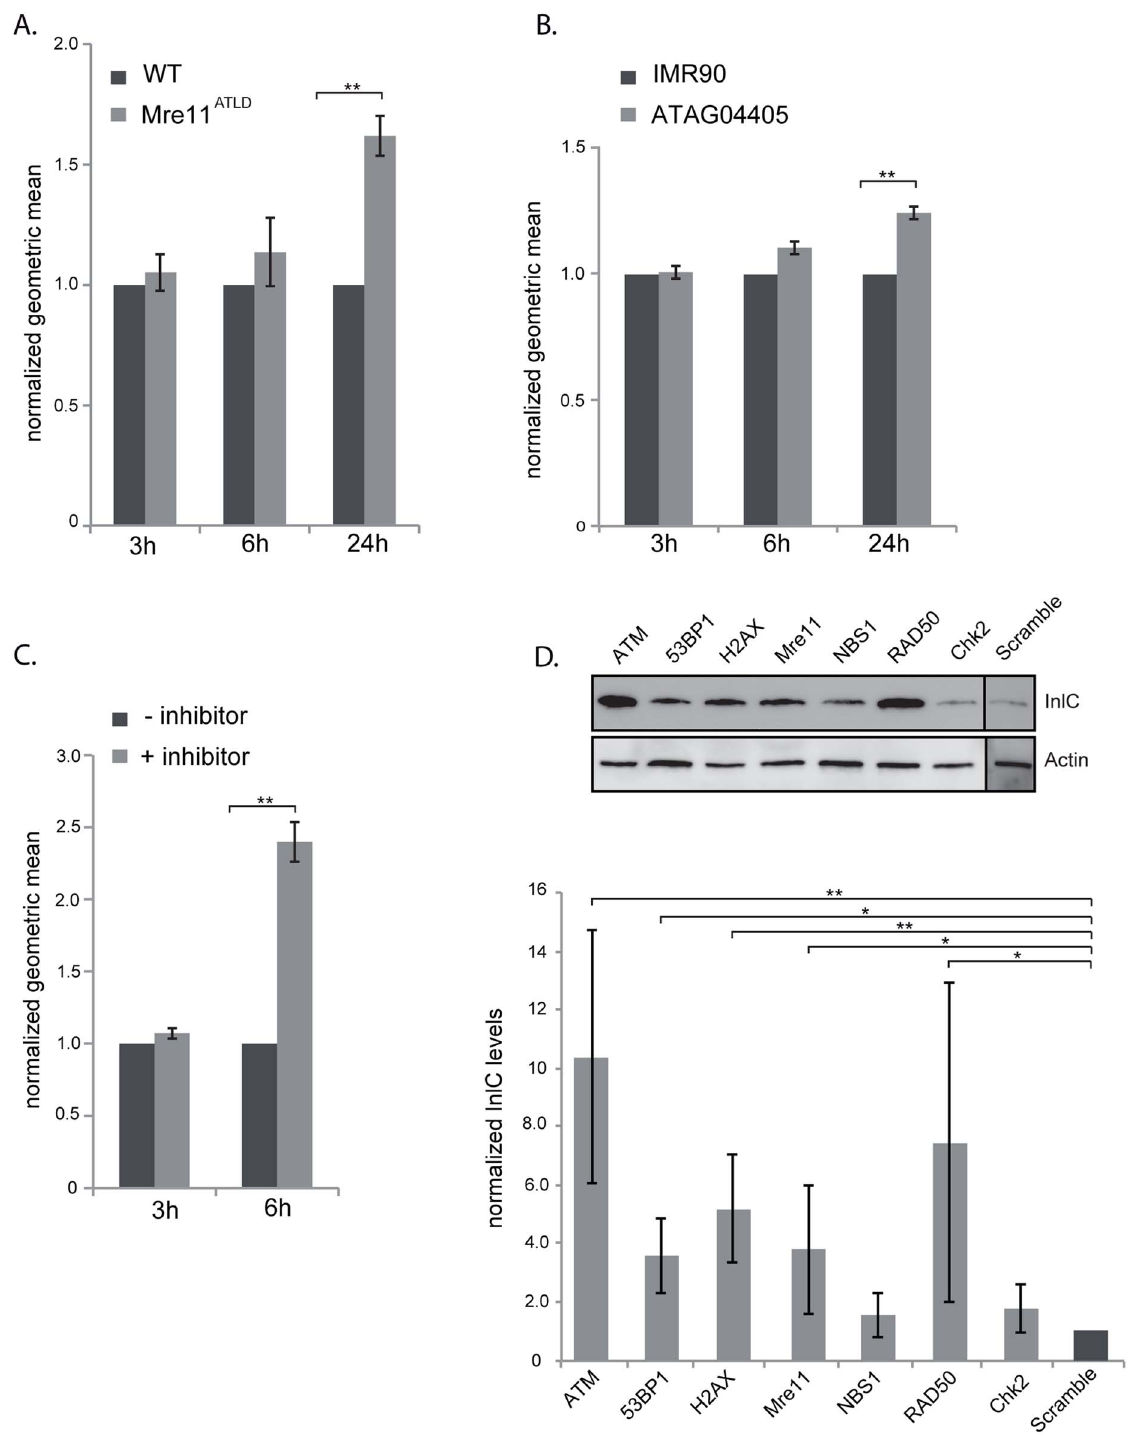
Figure 6. The DNA damage response is negative regulator of infection. (A) WT MEFs or Mre11 ATLD MEFs, or (B) WT human fibroblasts (IMR90) and fibroblasts bearing a mutation in ATM (ATAG04405) were infected with L. monocytogenes expressing GFP for the indicated times. FACS analysis was performed on infected cells and the geometric mean of 10,000 cells was measured using the FlowJo software. Results are normalized to uninfected cells and averaged over at least 3 independent experiments. (C) HeLa cells were infected with L. monocytogenes expressing GFP for the indicated times. The ATM inhibitor was added ( + inhibitor) 1 h after the start of infection. FACS analysis was performed on infected cells and the geometric mean of 10,000 cells was measured using the FlowJo software. Results are normalized to uninfected cells and averaged over at least 3 independent experiments. (D) HeLa cells were transfected with the indicated siRNA and infected with L. monocytogenes . Cells were collected after 24 h of infection and immunobloted for the Listerial protein InlC (top). Quantifications (bottom) are normalized to actin and to the scramble sample over at least 3 independent experiments. All quantifications in graphs show the mean + / 2 SEM (* indicates that p , 0.05, ** p , 0.01).